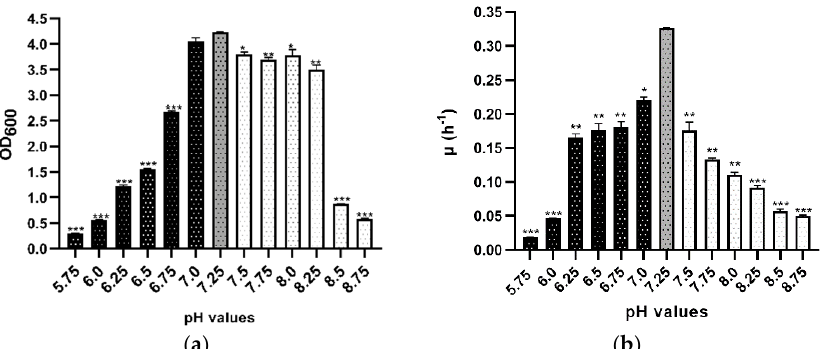
Figure 2. Effect of pH stress on the growth profile of Hfx. mediterranei R4 grown in Hm-DM. Data are based on three independent cultures. ( a ) Maximum OD 600 in stationary phase (reached at different times). ( b ) Average growth rate. Plotted values are the mean of triplicate measurements, and error bars represent ± SD. * p ≤ 0.05; ** p ≤ 0.01; *** p ≤ 0.001. In grey, the control; in black, acidic pH; in white, alkaline pH.